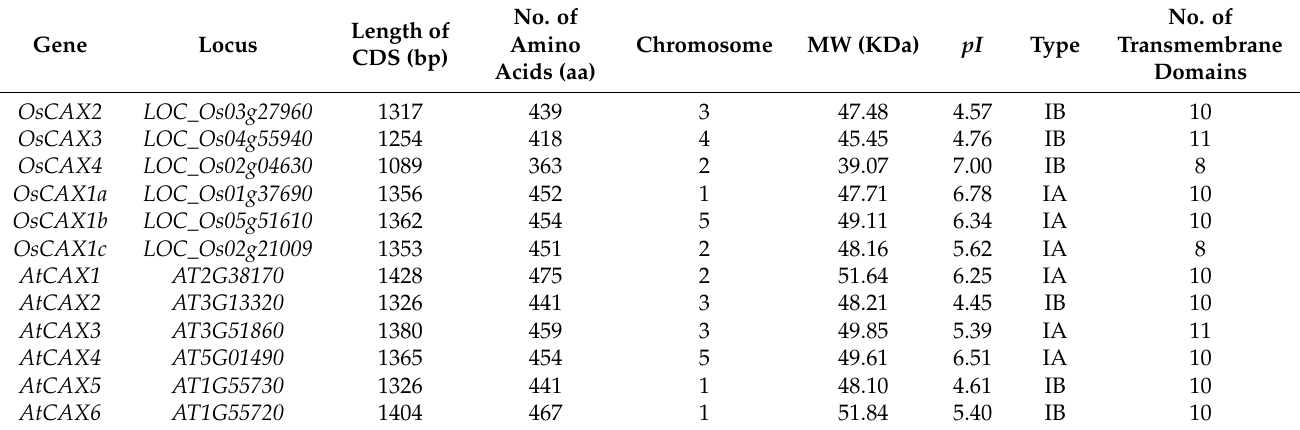
Table 1. Basic characteristics of CAX family genes in Oryza sativa and Arabidopsis thaliana . No. of Length of Amino Gene Locus CDS (bp)